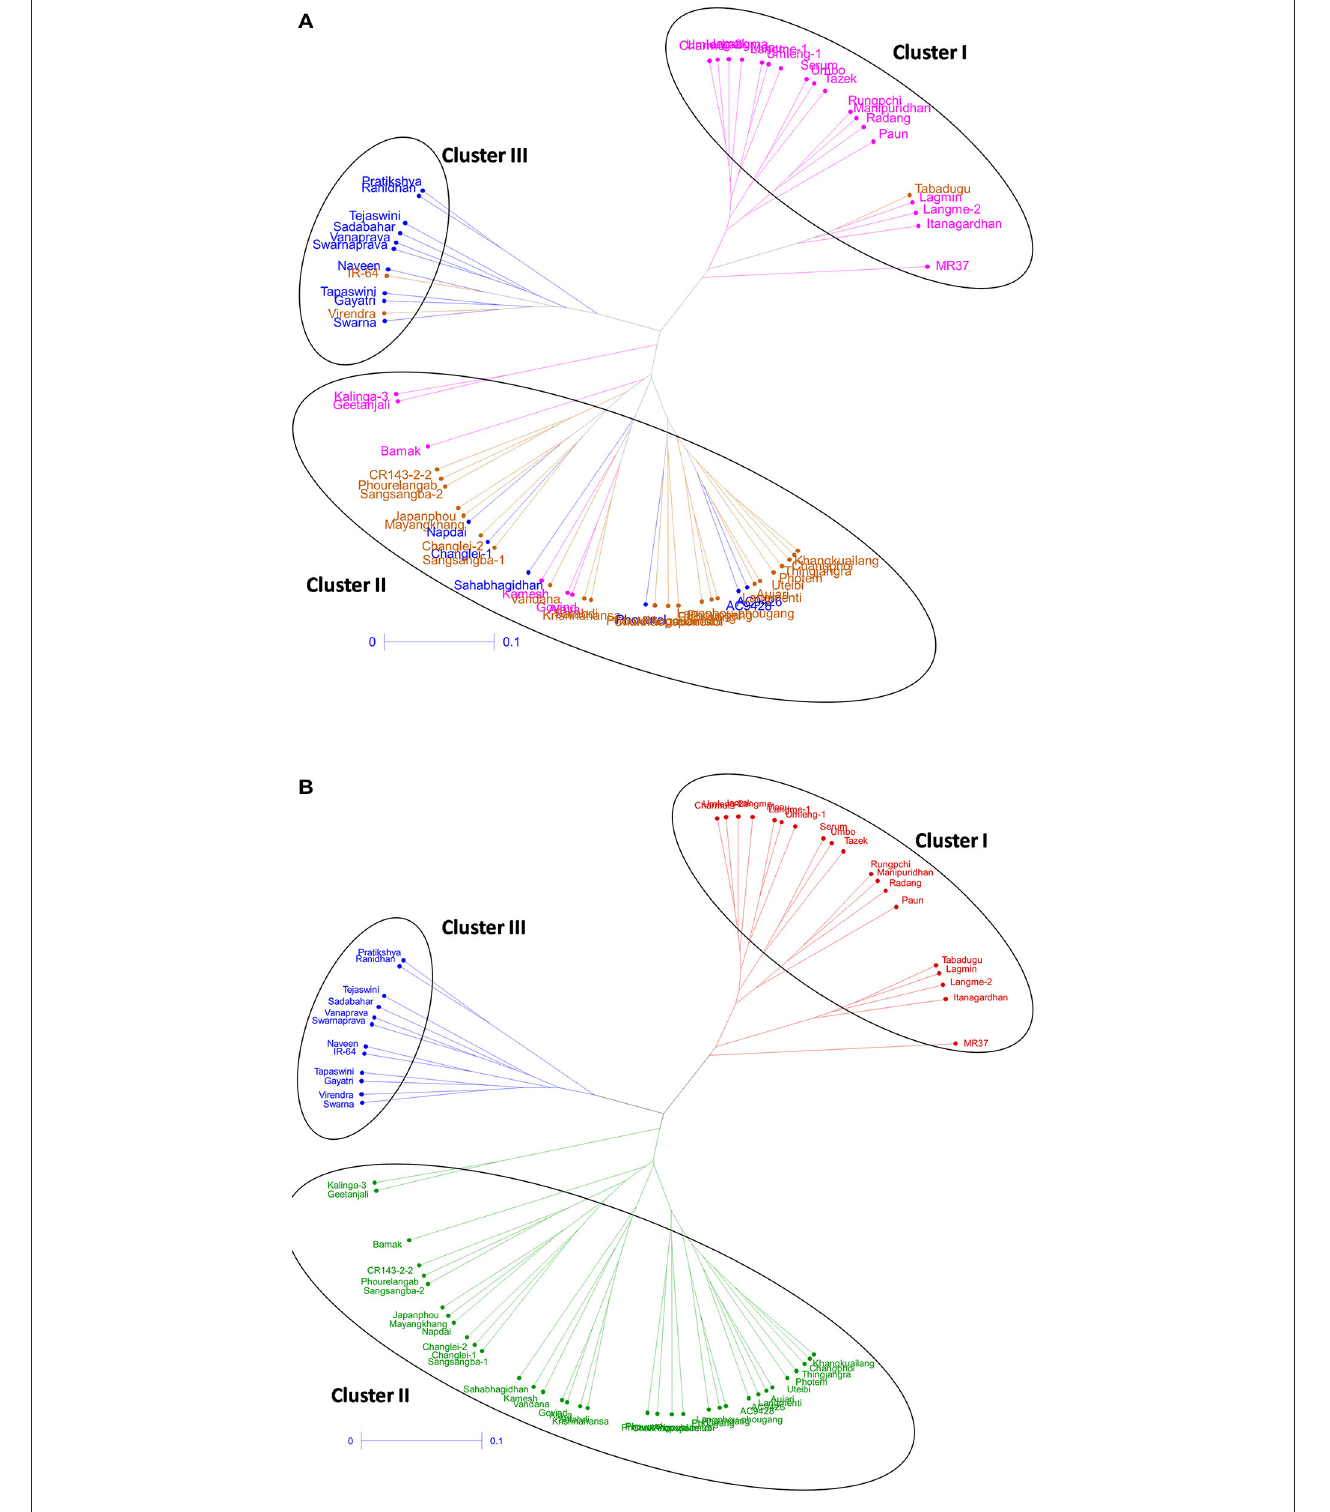
FIGURE 4 | Unrooted tree using UPGMA method showing the genetic relationship among 66 genotypes based on 60 molecular markers colored on the basis of (A) individual clusters from origin point and (B) sub-populations obtained from structure analysis (SP1-red; SP2-blue, and SP3-green).